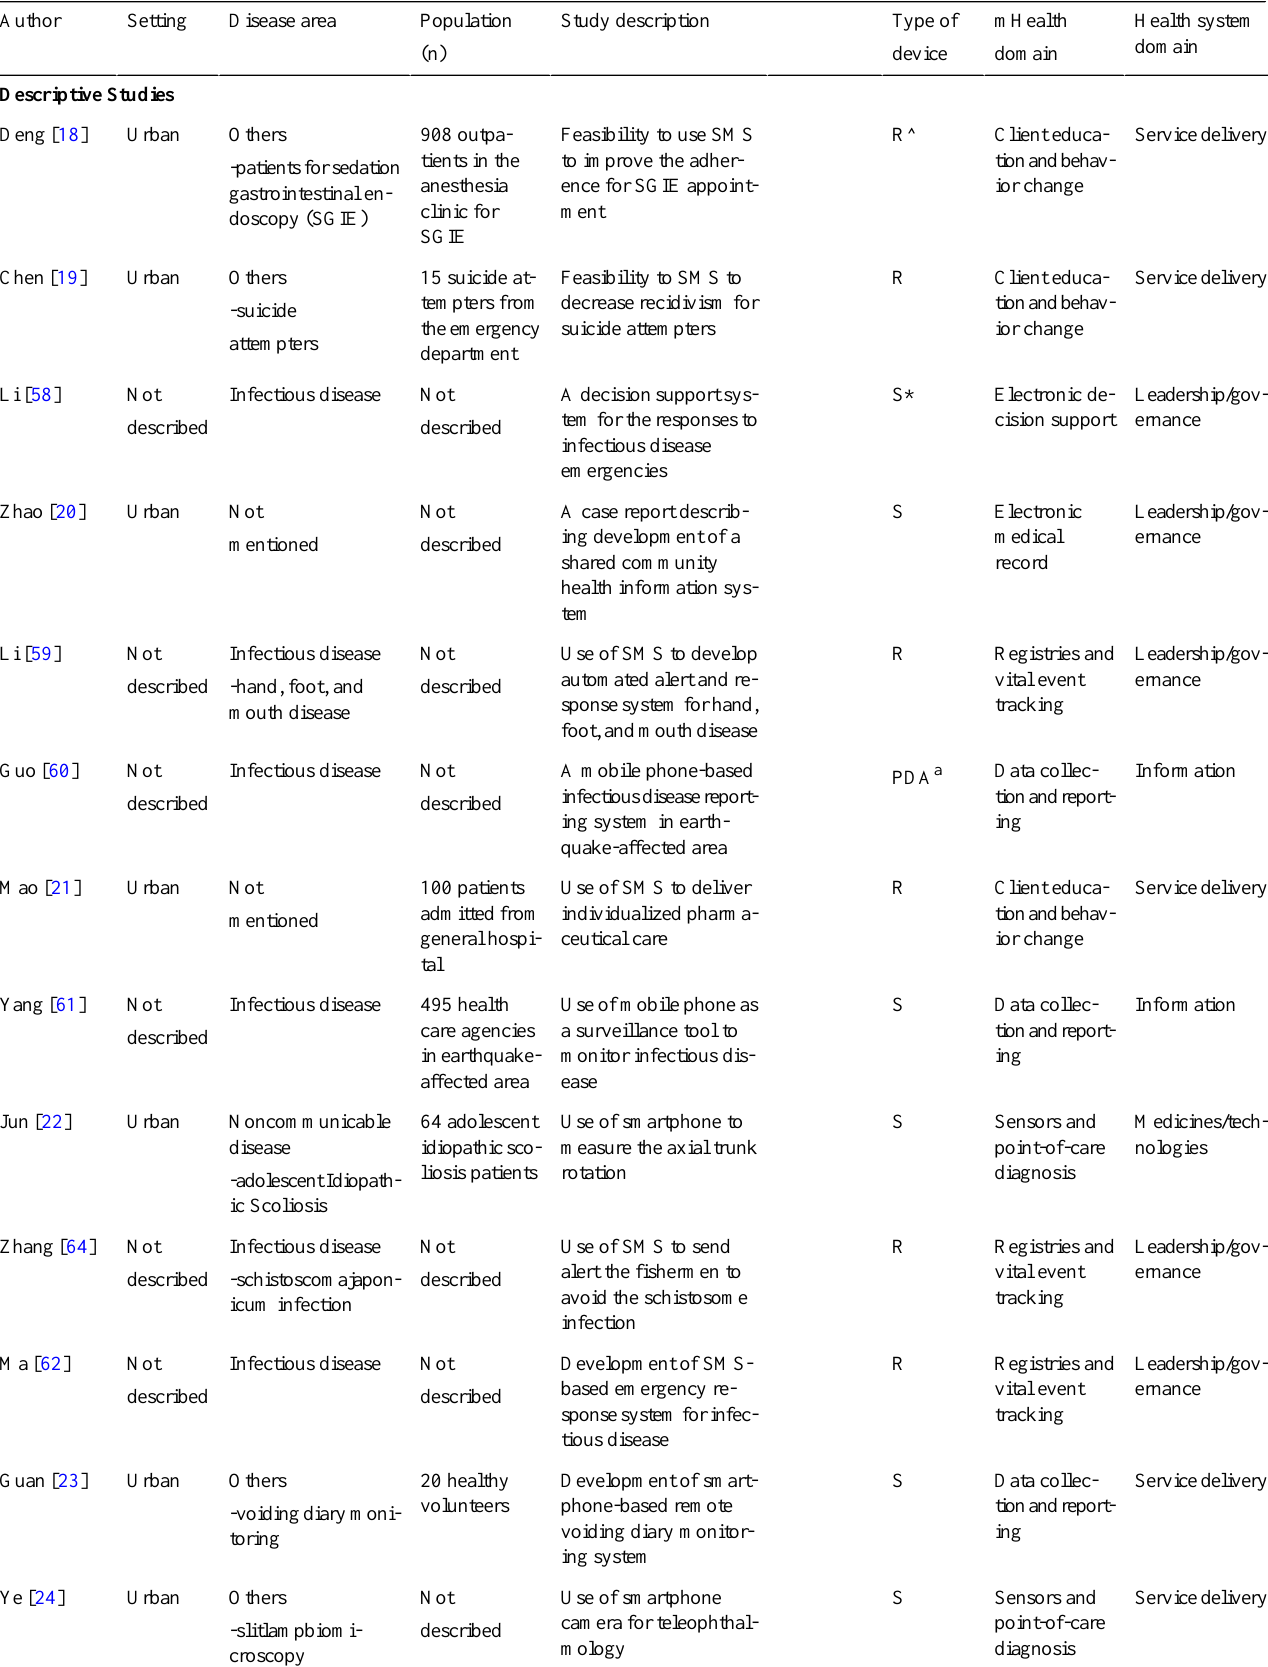
Table 1. Study characteristics, mHealth domain, and health system domain of nonprotocol